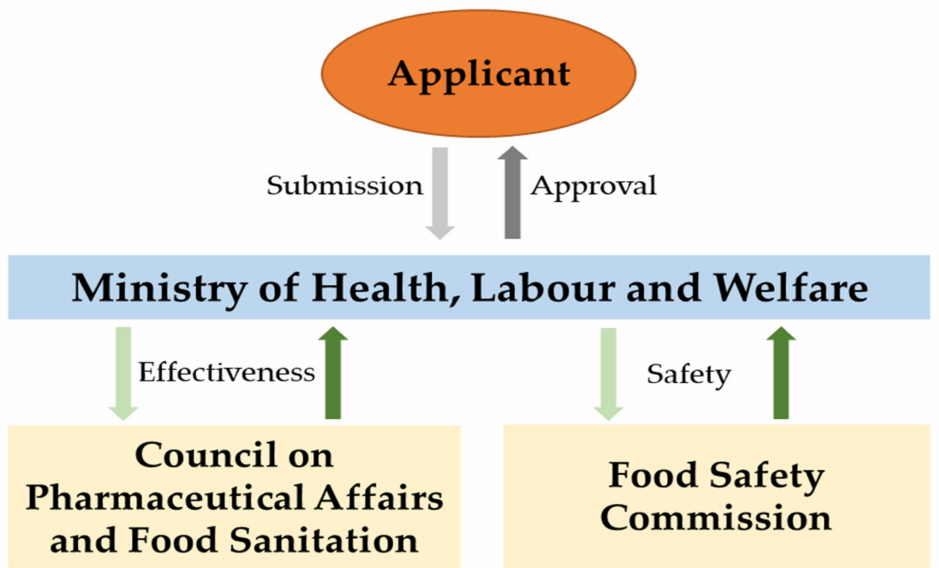
Figure 5. Summary of the procedures for the approval of FOSHU. Content of the image modified from the Japanese Ministry of Health, Labor and Welfare